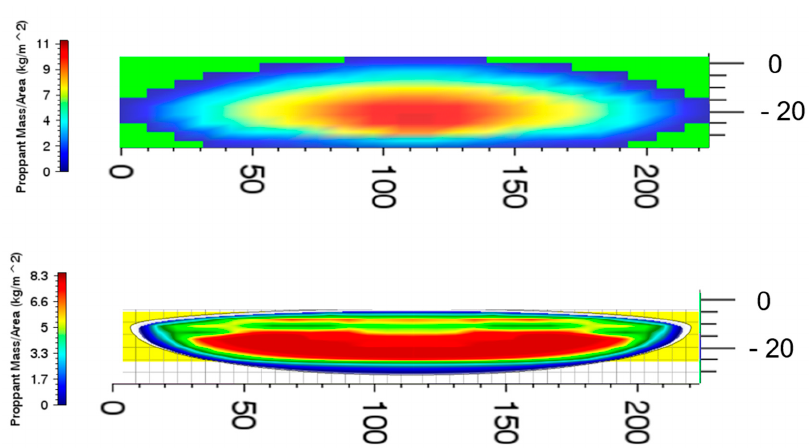
Table 3. Comparison of the fracture geometry factor between FracCSM and Fracpro PT.